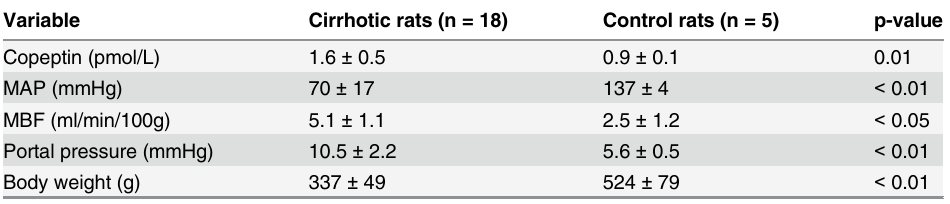
Table 1. Clinical and hemodynamic characteristics of cirrhotic rats and control rats at 18